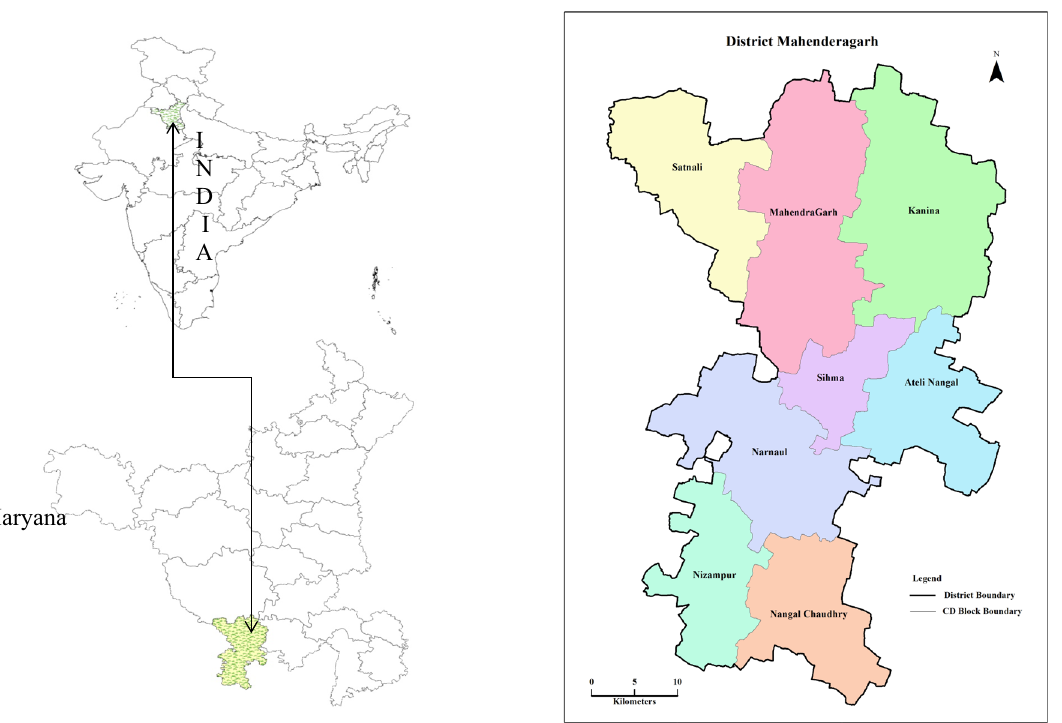
Fig. 1 Map of study area